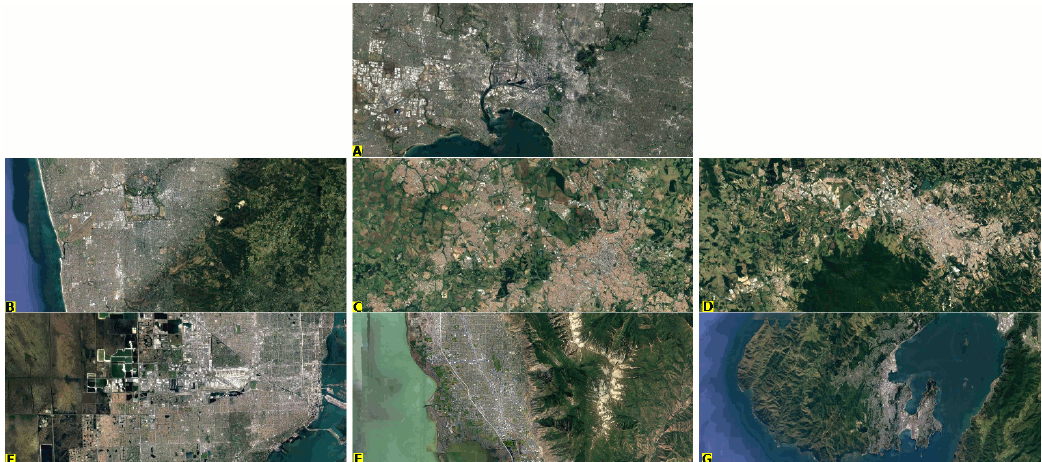
Figure 9. Satellite imagery of Melbourne, Australia ( A ), Adelaide, Australia ( B ), Campinas, Brazil ( C ), Jundiaí, Brazil ( D ), Miami, USA ( E ), Provo, USA ( F ), and Wellington, NZ ( G ) [51]. Note that the training imagery for the GM network was captured at a 400 × 400 m resolution (see Figure 1), not at the city-wide scale depicted